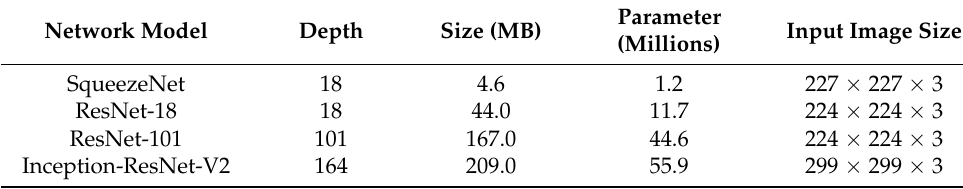
Table 2. Properties of pre-trained convolutional neural networks (CNNs).